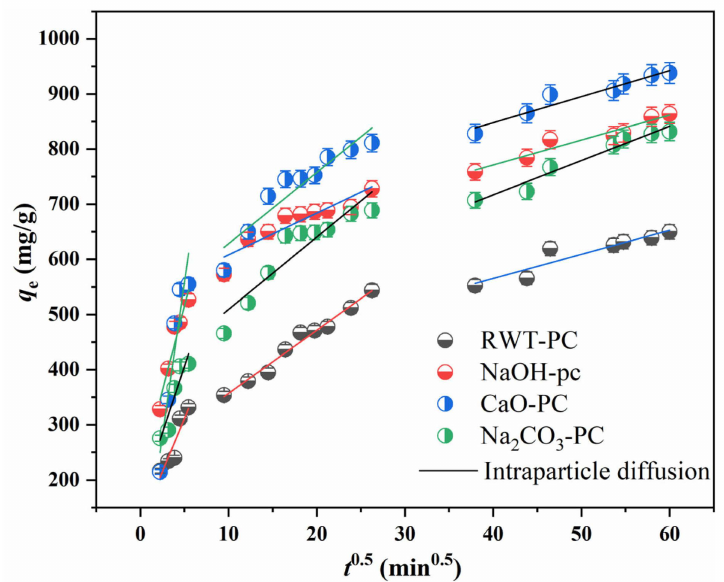
Figure 10. Intraparticle diffusion model of MG adsorption on PCs (Dosage = 40 mg, MG concentration = 1000 mg/L, and T = 301